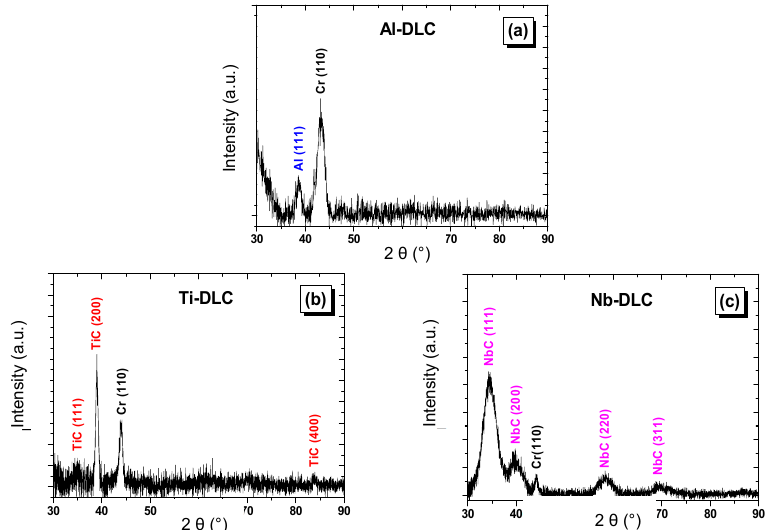
Figure 3. X-ray diffraction patterns of Me-DLC coatings: ( a ) Al-DLC, ( b ) Ti-DLC, and ( c ) Nb-DLC, corresponding to Al/C = 0.100, Ti/C = 0.140 and Nb/C = 0.180, respectively. The chemical bonds of pure DLC and Me-DLC films with different Me (Al, Ti) contents were analyzed by X-ray photoelectron spectroscopy (XPS). Figures 4 and 5 show the corresponding high- resolution C1s and Ti2p core level spectra respectively for Ti-DLC. Figures 6 and 7 show the C1s and Al2p high-resolution XPS spectra, respectively, of Al-DLC coatings. In this study, all spectra were calibrated at 285 eV (Csp 3 ). Figure 4. C1s X-ray photoelectron spectroscopy (XPS) spectra of ( a ) undoped DLC and Ti-DLC coatings: ( b ) Ti/C = 0.035 and ( c ) Ti/C = 0.105.